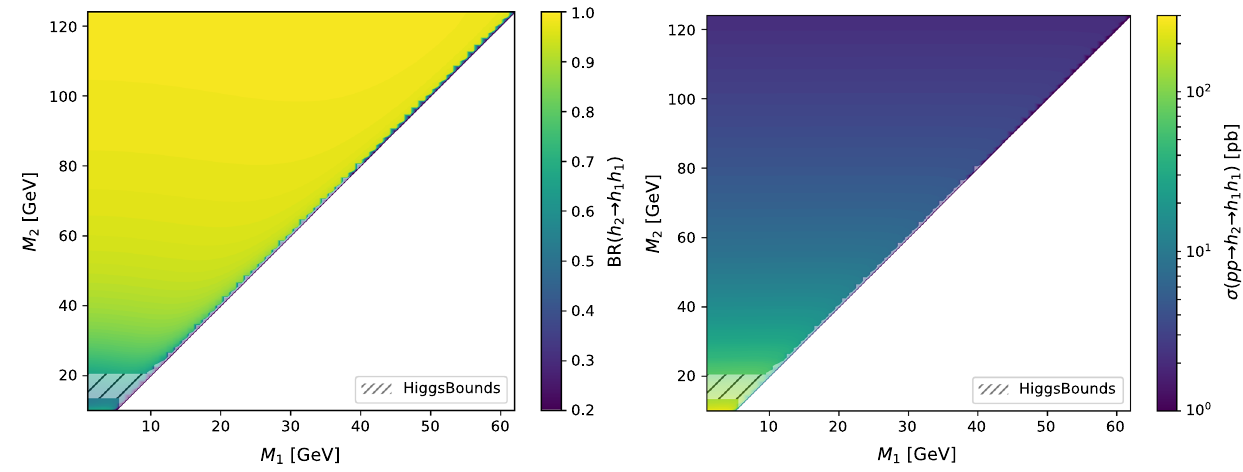
Fig. 11 Benchmark plane BP4 for the decay signature h 2 → h 1 h 1 with h 125 ≡ h 3 , defined in the ( M 1 , M 2 ) plane. The color code shows BR ( h 2 → h 1 h 1 ) (left panel) and the signal rate for pp → h 2 → h 1 h 1